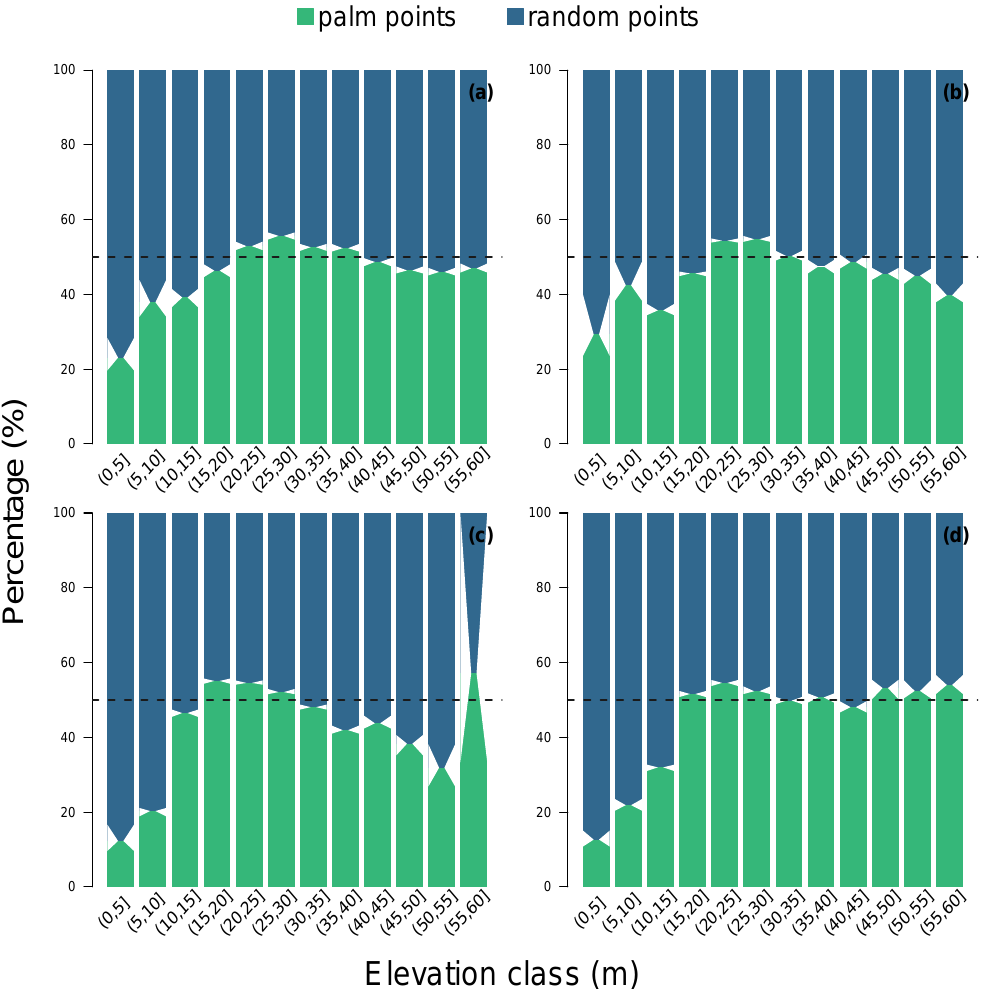
Figure 8. Comparison of the portion of observed canopy palms (%) in relation of the proportion obtained by random sampling over the same area, for the quantile classes of elevation. Elevation is given as relative to the river level (river level = 0 m). The analysis is given for four regions nearby river and wetlands (region 4, 5, 6 and 7, see Figure 5 for localization). N obs = 18,728 for region 4 ( a ), N obs = 14,832 for region 5 ( b ), N obs = 19,934 for region 6 ( c ) and N obs = 15,887 for region 7 ( d )) and the same number of random locations than N are sampled in each region. The random locations are bootstrapped 100 times to create the 95% confidence interval. For a given elevation class, if the confidence interval intersects with 50%, there is no significant difference between the distribution of palm and a random distribution for this class at 5% significance